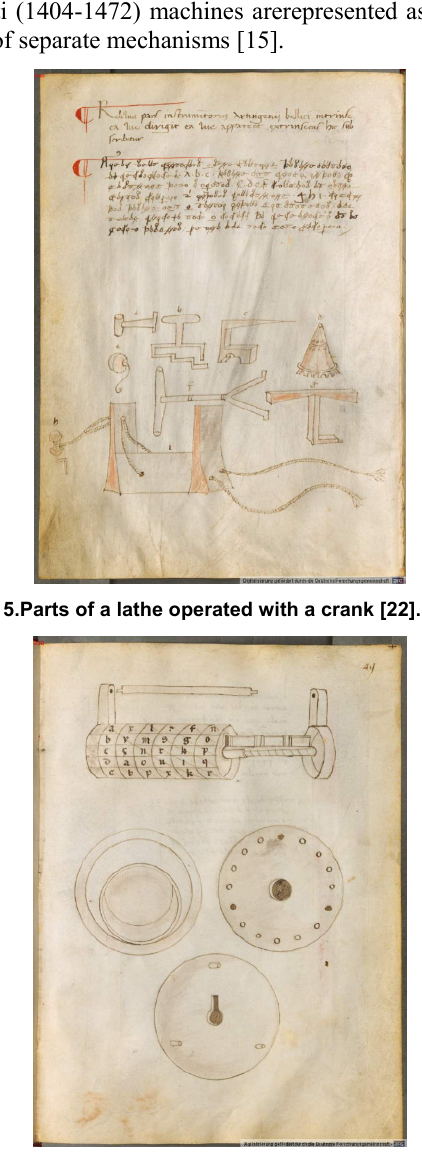
Figure 3. A self-propelled car [22].